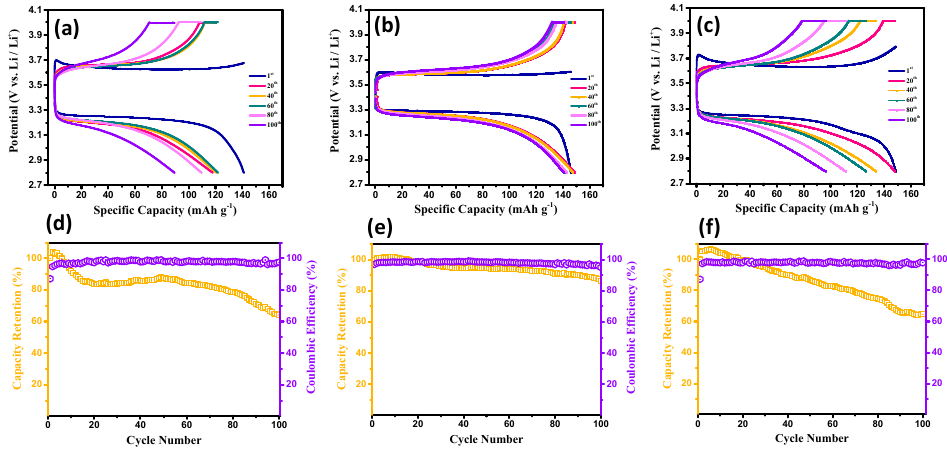
Figure 6. Typical charge-discharge curves and cyclic performance of the test cells equipped with CSEs (PVDF-HFP/LATP= 2.0) of 5 wt.% C ( a , d ), 7 wt.% C ( b , e ), and 15 wt.% C ( c , f ).